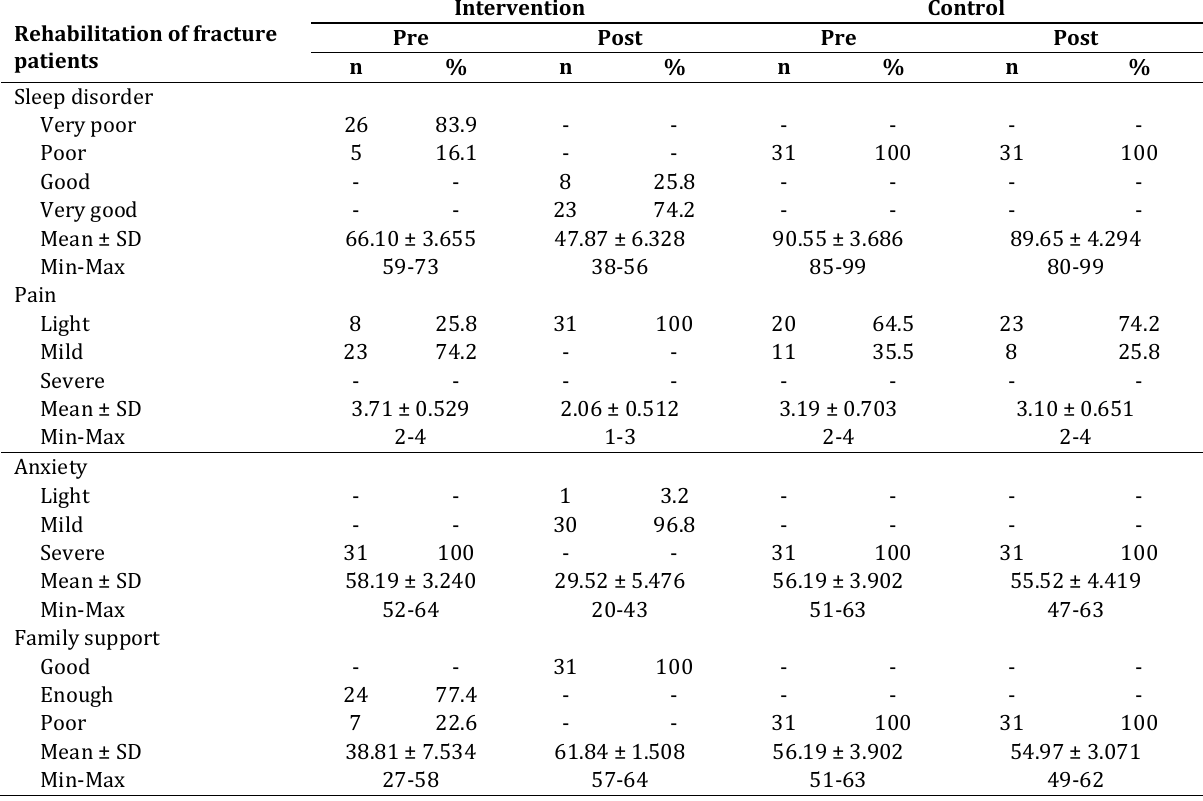
Table 2. The Distribution Frequency and Percentage on Patients' Rehabilitation of Fractures among the Intervention Group and the Control Group before Receiving the Nursing Intervention based on the Levine Model (n=62) Rehabilitation of fracture